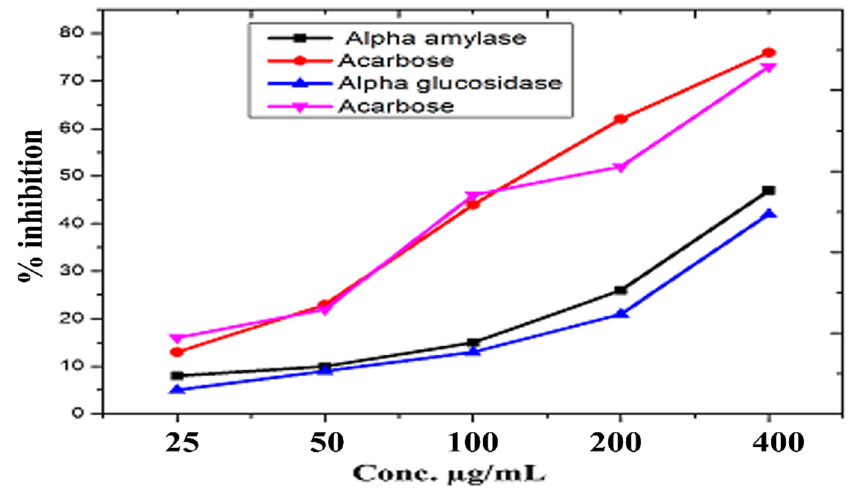
Figure 9. α -amylase and α -glucosidase inhibitory potential of ZnO-NPs.